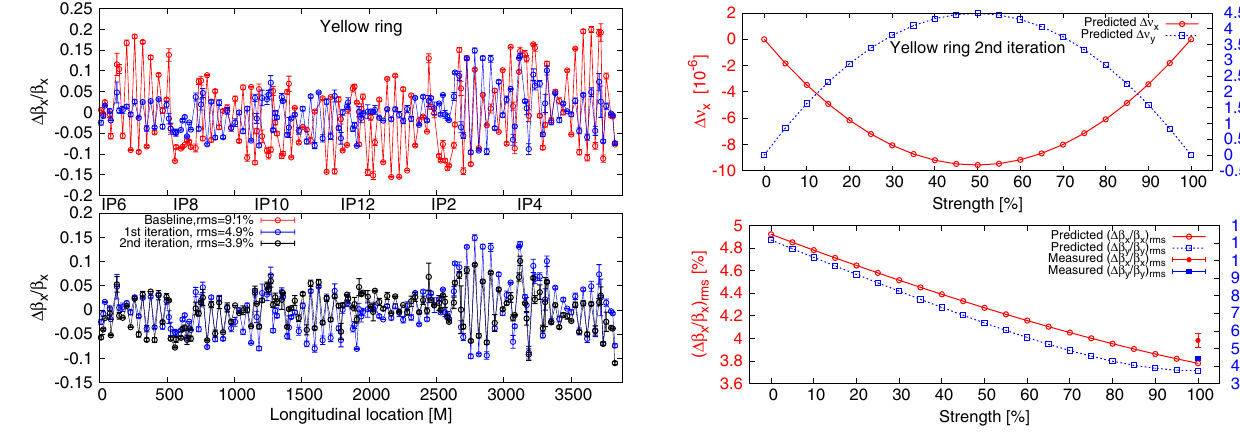
FIG. 9. Simulated evolution of tunes and rms beta-beat along a ramp-up process of the computed second iteration of corrections for the Yellow ring. The rms measured beta-beat with error bars at 100% of correction strength is also